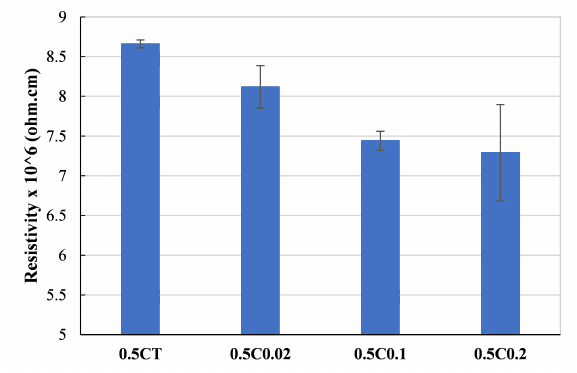
Figure 5: Electrical resistivity of